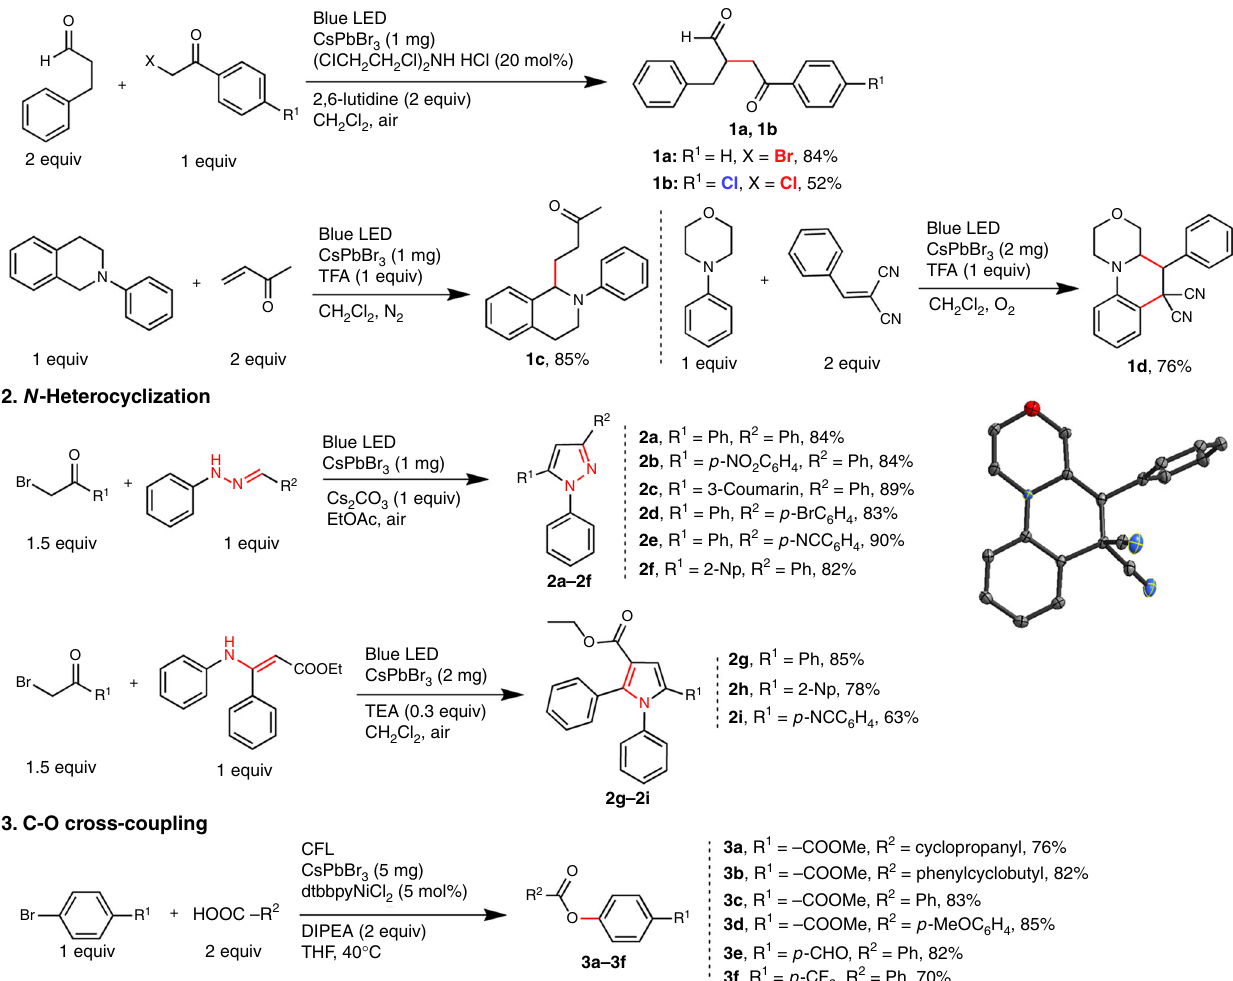
Fig. 1 The library of C – C, C – N, and C – O bond formation reactions and respective yield. (Yields of 1a , 1c , 1d , 2a , 2g , 3a are the average yields of three reactions, see Supplementary Table 8; Inset: perspective view of 1d ’ s single crystal structure with the thermal ellipsoids drawn at 50% probability level and the H atoms omitted for